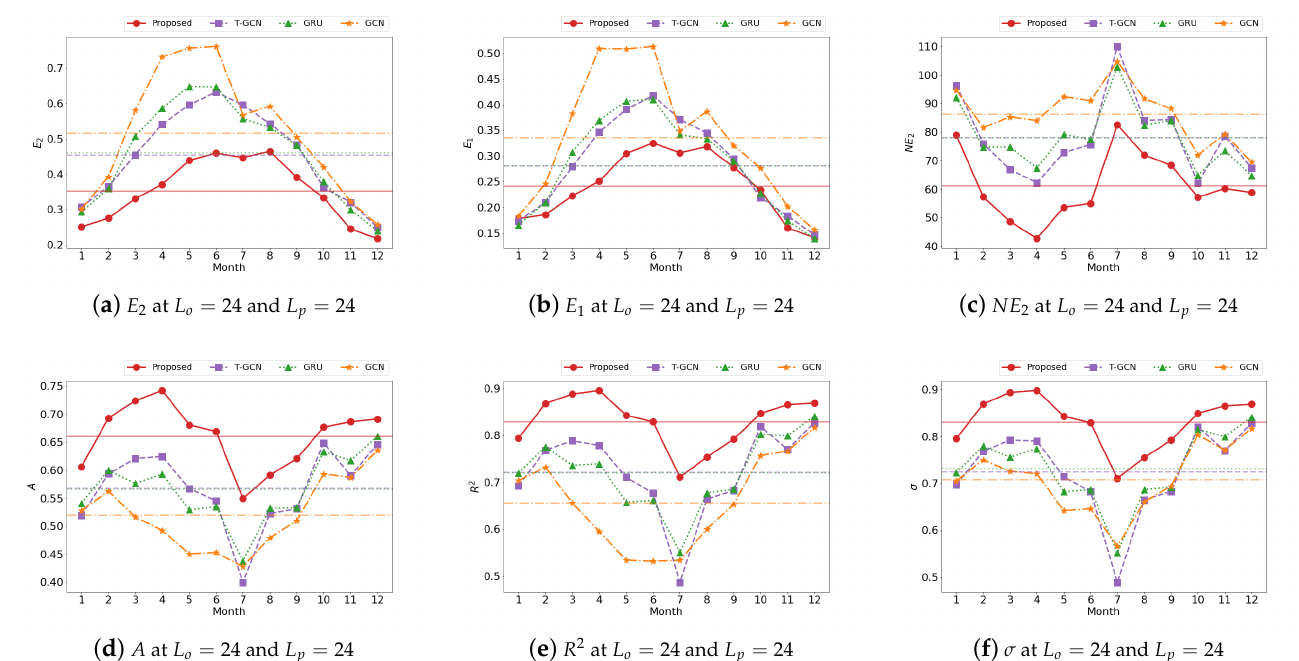
Figure A5. A comparison of the performance stability of the proposed model with the existing models according to the month. X-axes of the plots indicate the month, and Y-axes correspond to the evaluation metrics. The translucent horizontal lines indicate average performance of the